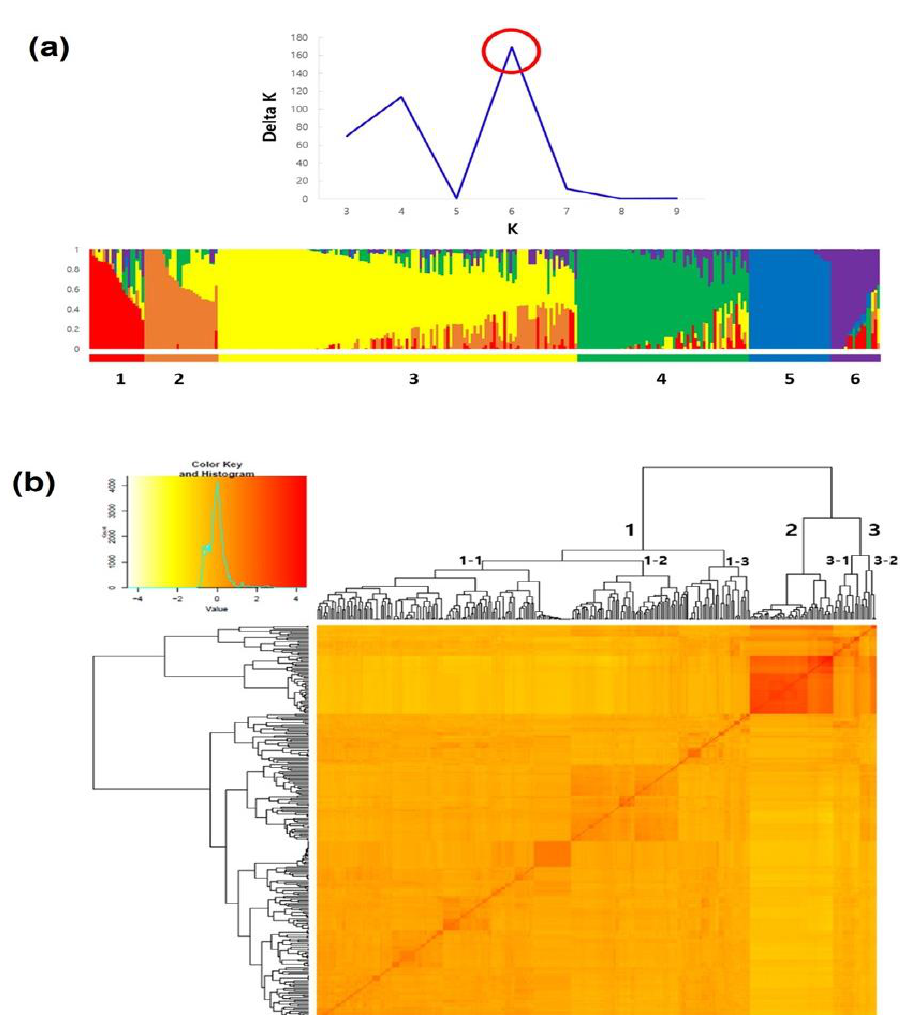
Figure 4. ( a ) Delta K graph calculated using the Evanno method ( top ) and optimal population structure (delta K = 6) cluster plot ( bottom ). The optimal population number has been indicated using a red circle; ( b ) Kinship heatmap plot and dendrogram for 290 accessions drawn using the genotype data of 11,912 SNPs. The genetic distance between accessions was calculated using the VanRaden algorithm.